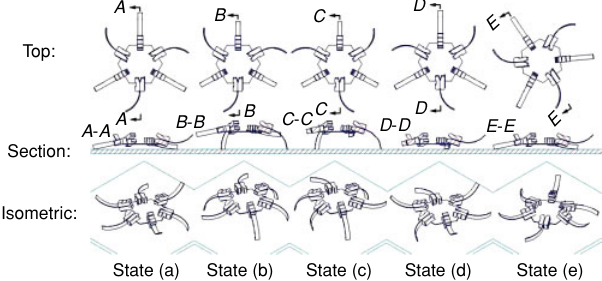
Figure 14 One-step cycle of rotating motion of the robot.